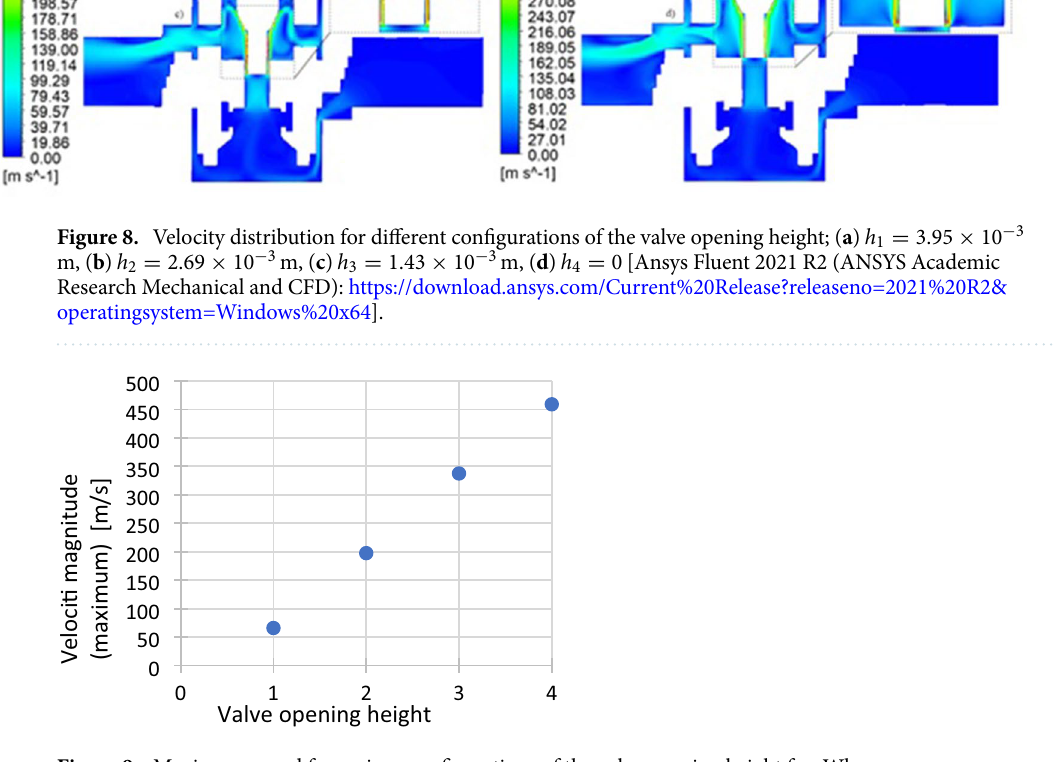
3 m, 4 h 1.43 10 3 − − = ×